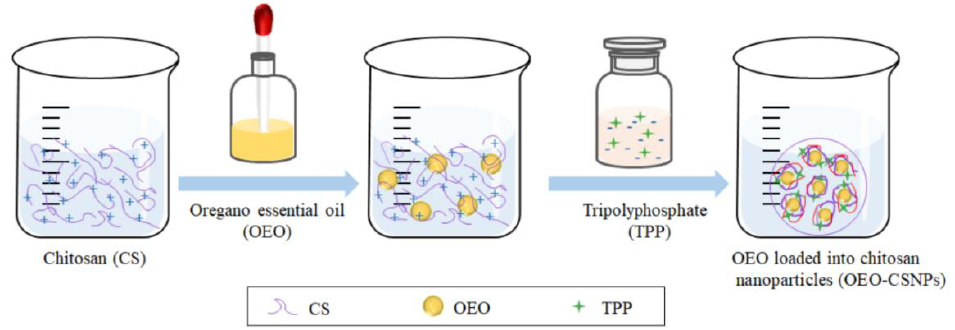
Figure 1. The formation process of